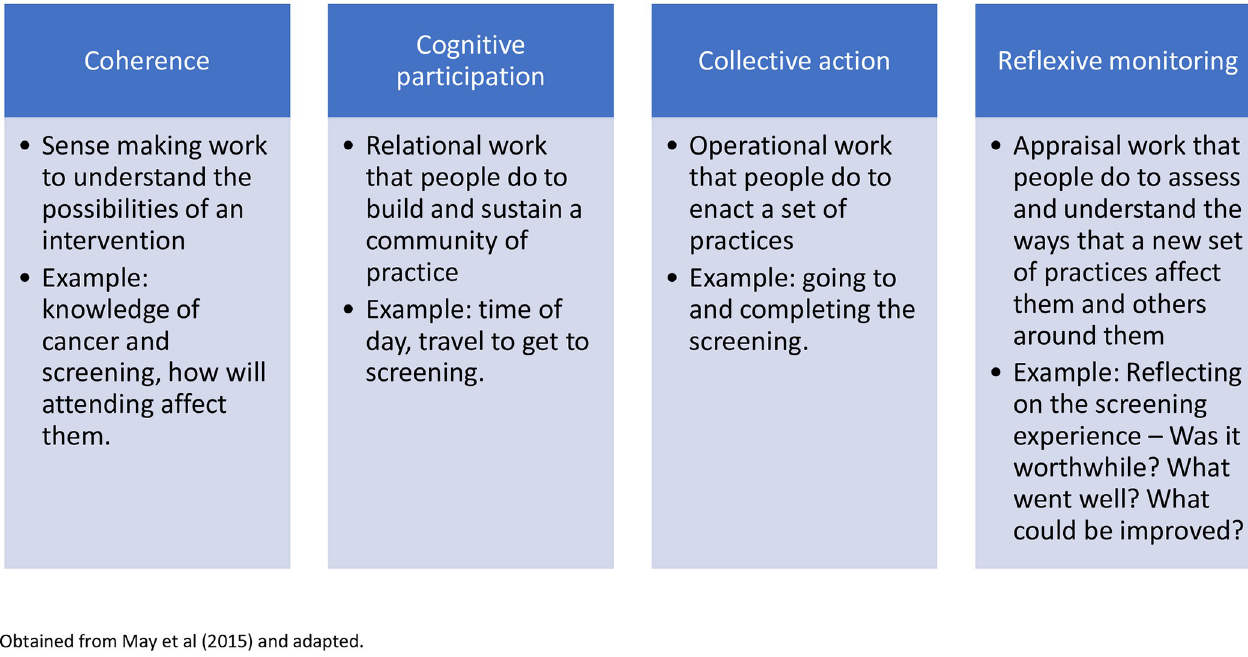
Fig 2. Constructs of